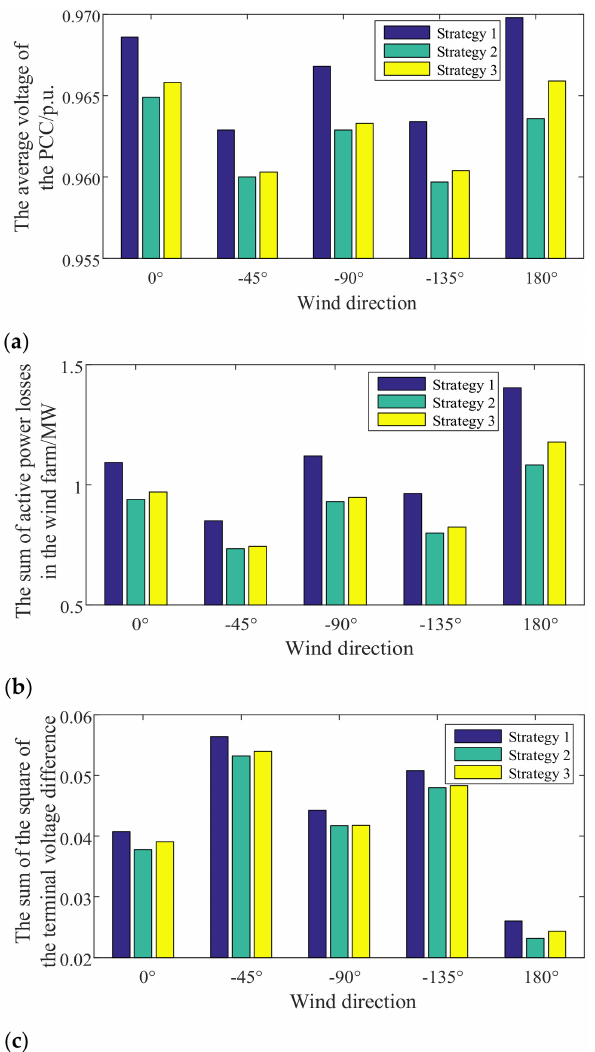
Figure 15. ( a ) The average voltage of the PCC under the three different strategies; ( b ) The sum of active power losses in the wind farm under the three different strategies; ( c ) The sum of the square of the terminal voltage difference under the three different strategies. The comparison of the indicator calculation results of the three